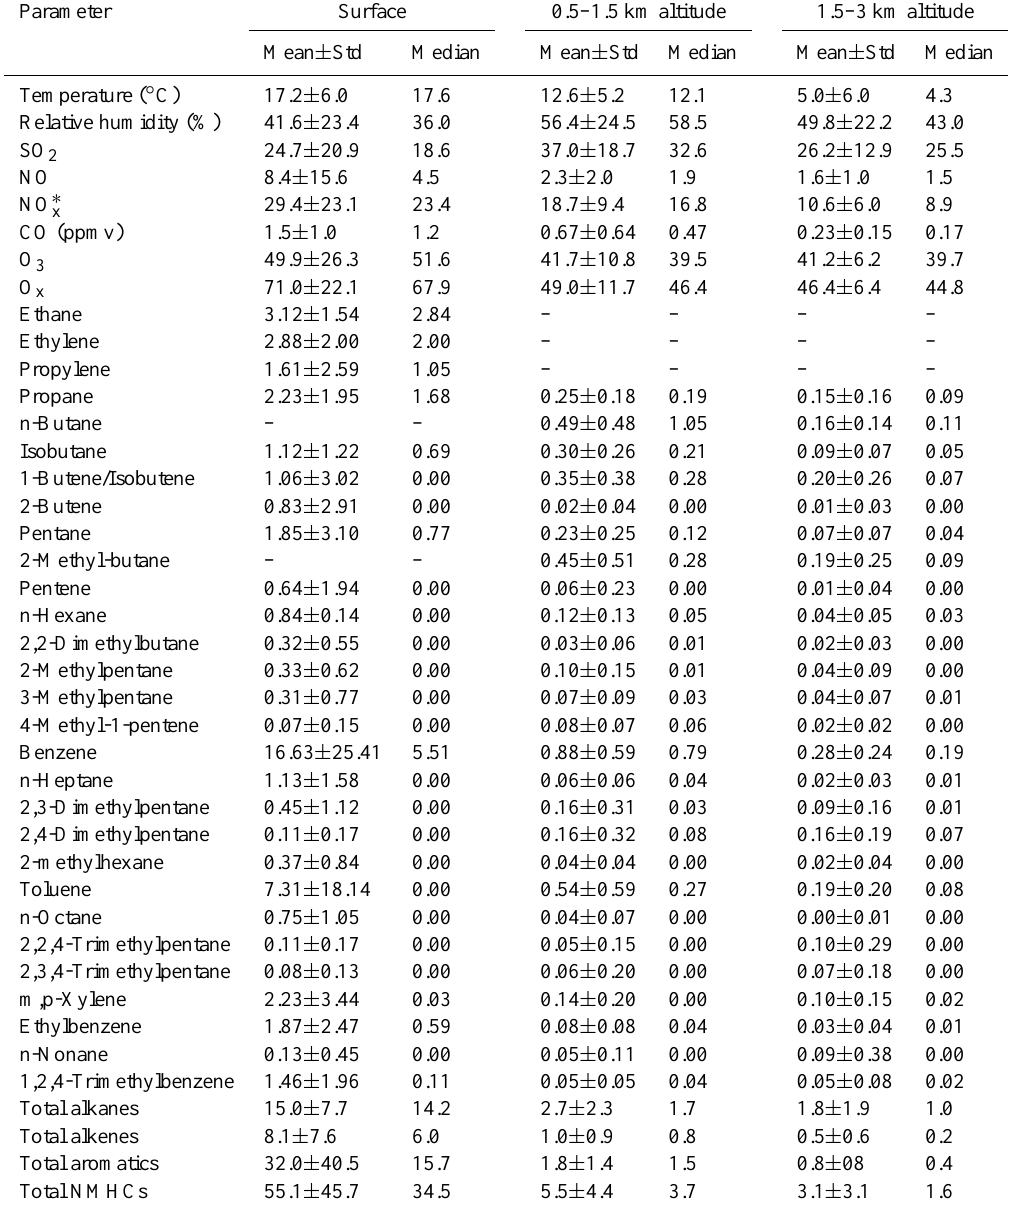
Table 3. Summary of daytime meteorological parameters and trace gas mixing ratios (mean value plus/minus standard deviation, and median value of the data) observed during